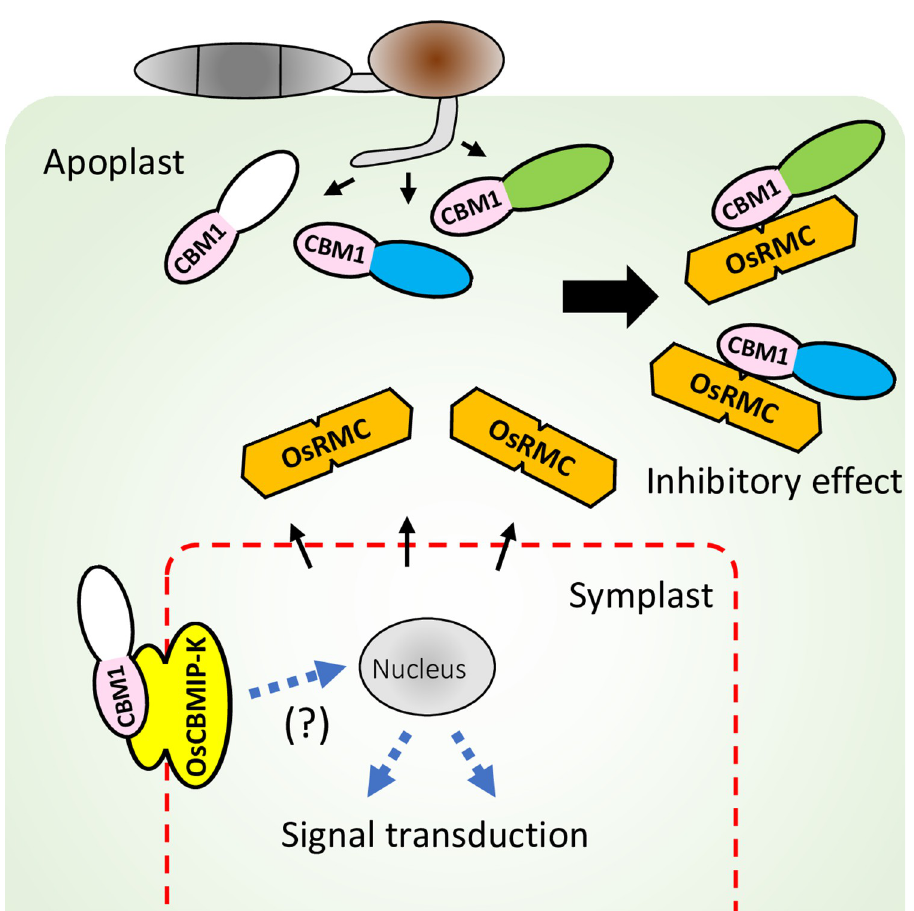
Fig 10. Model of the action of CBM1-binding proteins. Various CBM1-containing CWDEs are secreted from M . oryzae . OsRMC is secreted to apoplastic space and binds to CBM1 of the enzymes, resulting inhibition of the enzymatic activities. OsCBMIP-K binds to CBM1 of the enzymes and may potentially be involved in signal